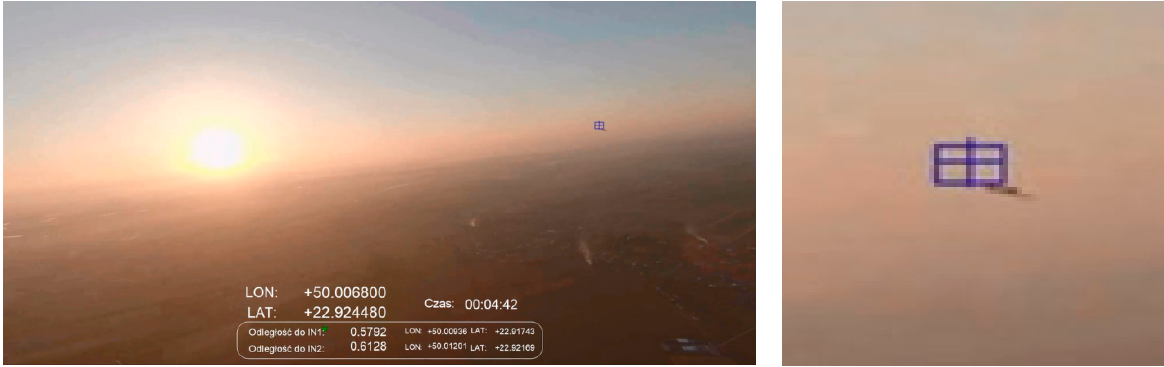
Figure 10. Scenario related to Figure 5C; sunset, altitude ~500 m, distance to intruder: 579 m.